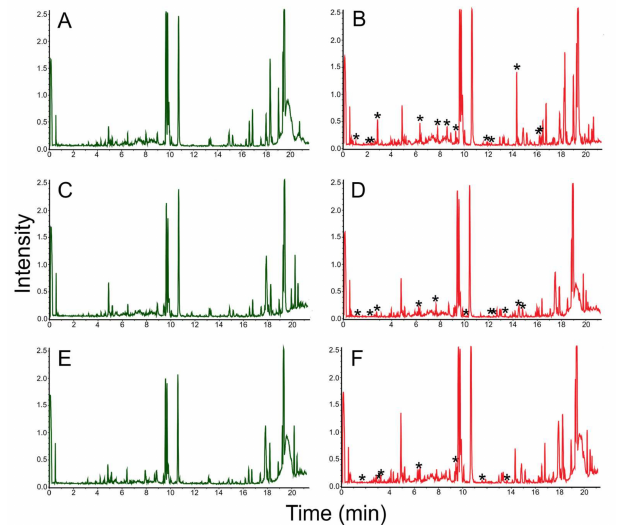
Figure 9. Chromatograms of natural products extracted from MM with birch sawdust added (left column, control parameters) and MM (left column, experimental parameters) where Rhodococcus sp. LPB2019K201-3 was cultivated: ( A ) MM media without sawdust (control); ( B ) Rhodococcus sp. LPB2019K201-3 cultivated on MM media without sawdust (control); ( C ) MM media with a relatively low content of birch sawdust (control); ( D ) Rhodococcus sp. LPB2019K201-3 cultivated on MM media with a relatively low content of birch sawdust; ( E ) MM media with a relatively high content of birch sawdust (control); ( F ) Rhodococcus sp. LPB2019K201-3 cultivated on MM media with a relatively high content of birch sawdust. *-asterisks indicate the differences (new peaks) between MS-spectrums of control and experimental